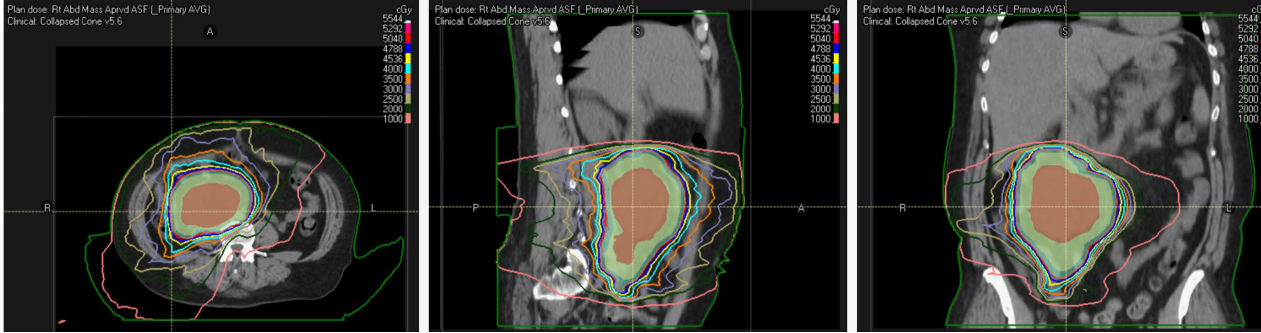
Figure 1. Representative axial ( A ), sagittal ( B ), and coronal ( C ) views of a VMAT radiation treatment plan generated used to preoperatively treat a patient with a right-sided retroperitoneal, recurrent, well-differentiated liposarcoma. The red color wash represents the gross tumor volume (GTV), and the yellow and blue color wash indicates the expansions used for the clinical target volume (CTV) and planning target volume (PTV), respectively. The PTV was prescribed to receive a total of 5040 cGy in 28